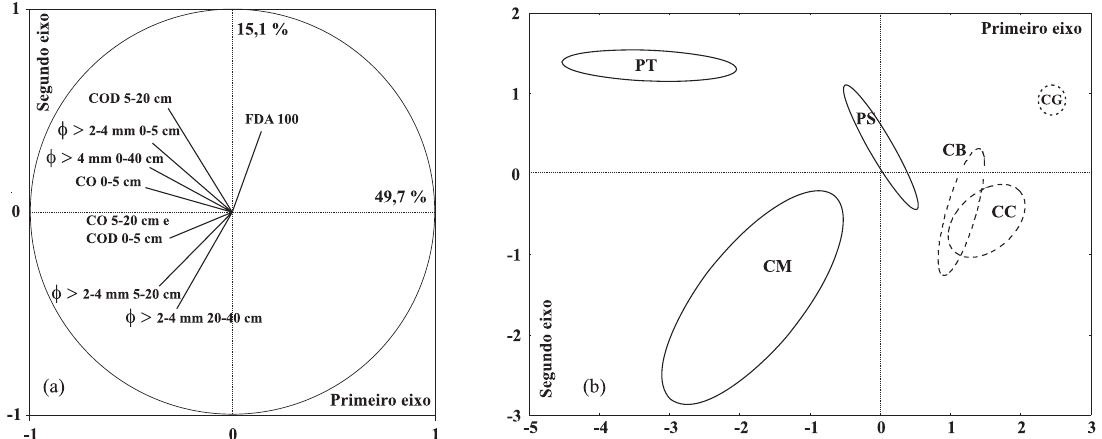
Figura 2. Análise de componentes principais de variáveis associadas a compartimentos orgânicos do solo e atividade microbiana – amostras de 18 sítios de restinga. (a) Círculo de autovetores das variáveis (CO: C orgânico da terra fina; COD: C orgânico dissolvido; φ φ φ φ φ > 2–4 mm e φ φ φ φ φ > 4 mm = fragmentos orgânicos > 2– 4 mm e > 4 mm, respectivamente; FDA 100 = atividade microbiana pela hidrólise do diacetato de fluoresceína, dose de 100 mg, amostras de 0 a 10 cm de profundidade); (b) Plano de elipses de cada grupo de sítios – CM: Caju, mata; CG: Caju, capim-gengibre; CB: Caju, coqueiral do banco de germoplasma; CC: Caju, capoeira; PT: Pirambu, mata de topo; e PS: Pirambu, mata de